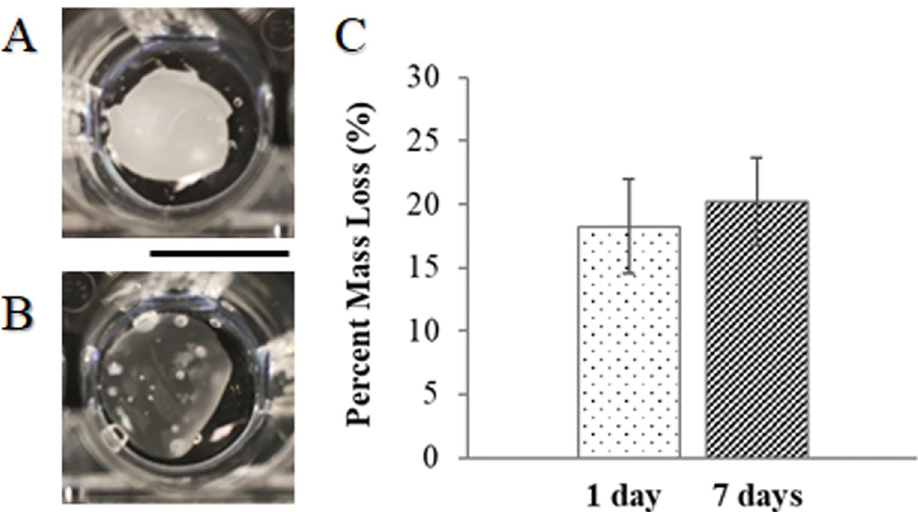
Fig 5. Aqueous stability and observable phase transition of cured PNIPAM nanofiber scaffolds after 1 or 7 days of immersion in deionized water. Qualitative scaffold images taken at 24 hours at 37˚C above LCST (A) and 22˚C, below LCST (B). Scale bar is 1cm. Aqueous stability is quantified as percent mass loss (C). Mass loss does not change significantly with increasing time in culture (p =